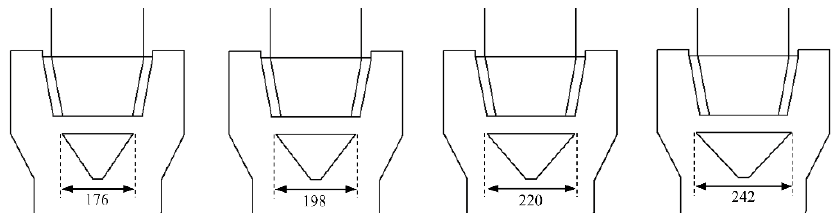
Figure 21. Structure of the diversion cone at different diameters (T-C (1-0.8) ).